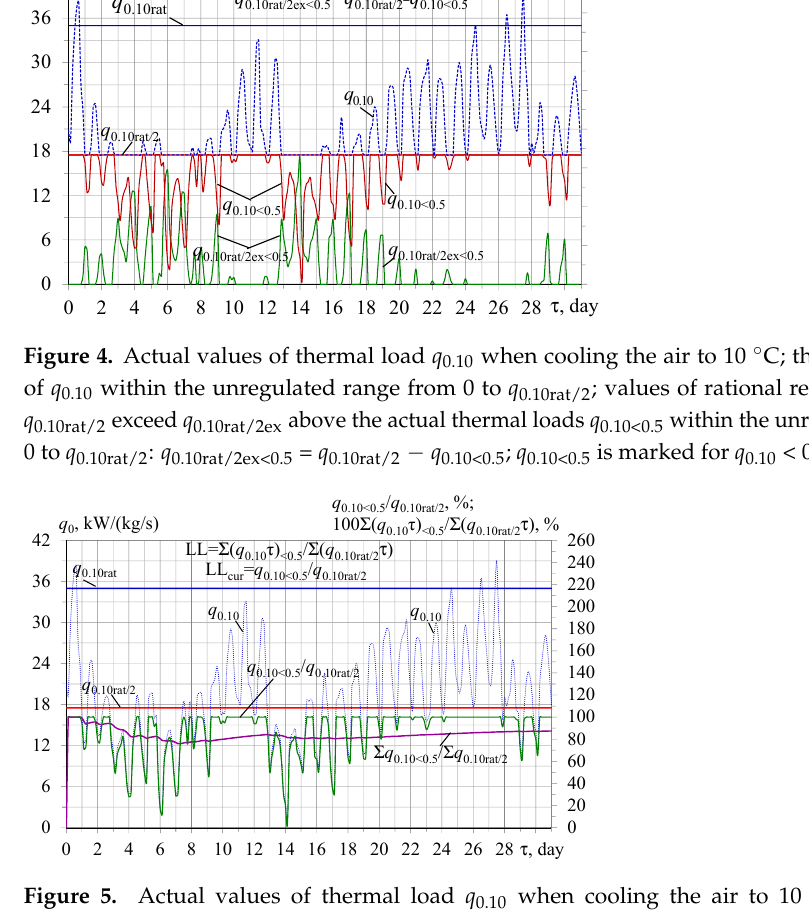
Figure 4. Actual values of thermal load q 0.10 when cooling the air to 10 ° С ; the rest parts q 0.10 ˂ 0.5 of q 0.10 within the unregulated range from 0 to q 0.10rat/2 ; values of rational refrigeration capacity q 0.10rat/2 exceed q 0.10rat/2ex above the actual thermal loads q 0.10 ˂ 0.5 within the unregulated range from 0 to q 0.10rat/2 :